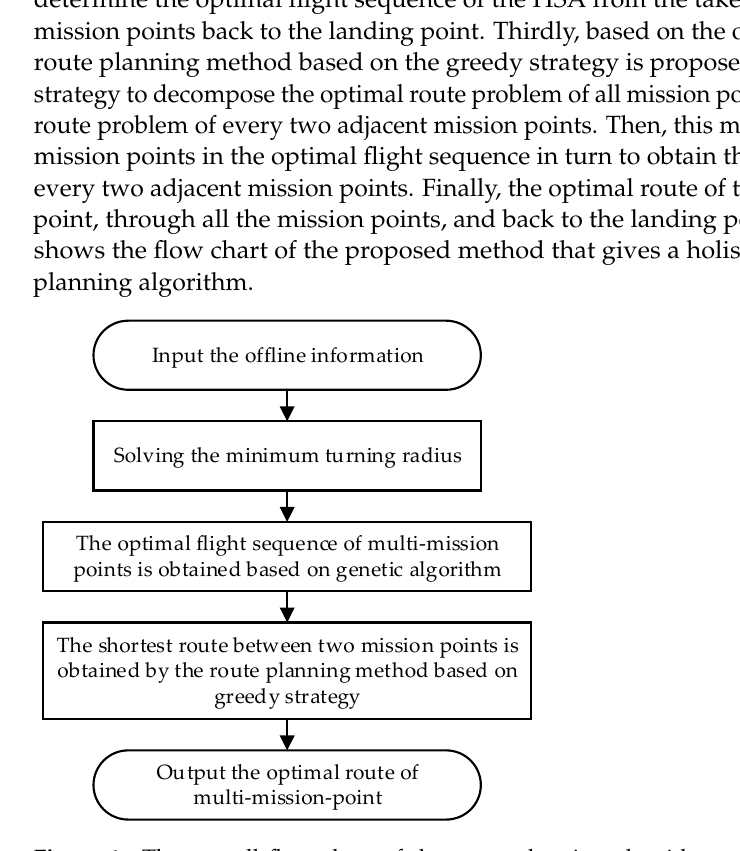
Figure 1. The overall flow chart of the route planning algorithm proposed. The input offline information includes HSA take-off and landing points and route mission points, the minimum flight speed, and the maximum turning slope angle of the HSA during turning.